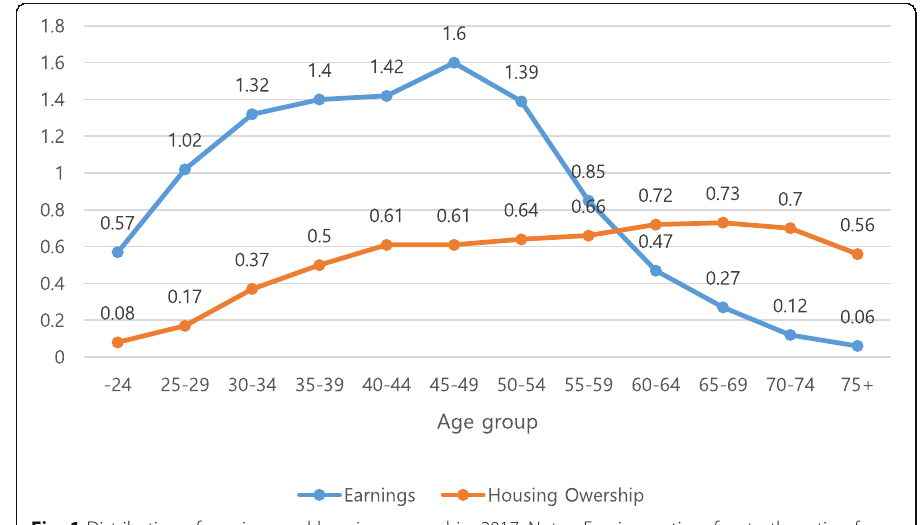
Fig. 1 Distribution of earnings and housing ownership, 2017. Notes: Earnings ratio refers to the ratio of earnings relative to average earnings, and the ratio of housing ownership indicates the proportion of housing owners among each age group